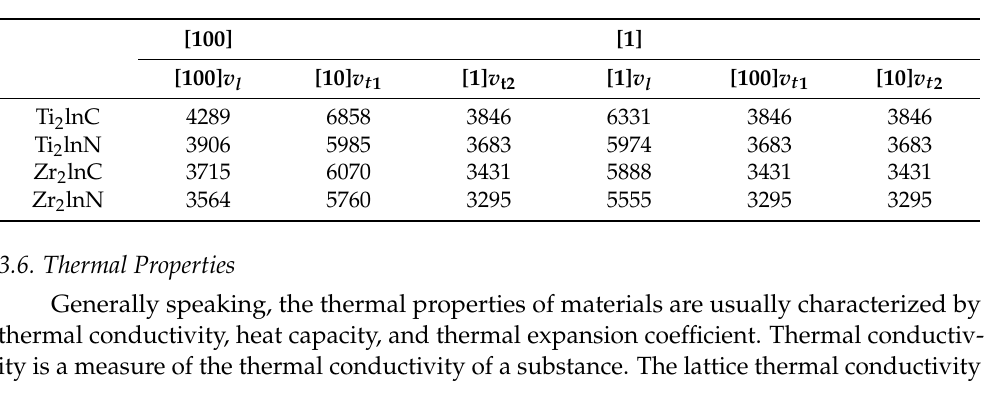
Table 7. Anisotropic sound velocities (m/s) of M 2 InX (M = Ti, Zr and X = C, N) MAX